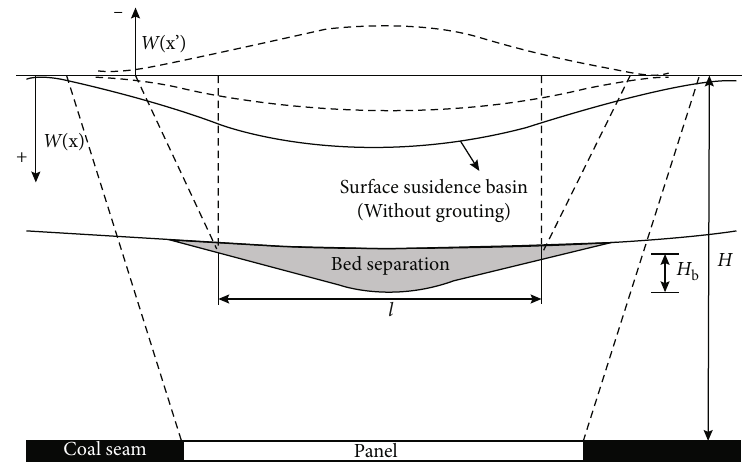
Figure 2: Overburden grouting equivalent calculation model (OGECM).